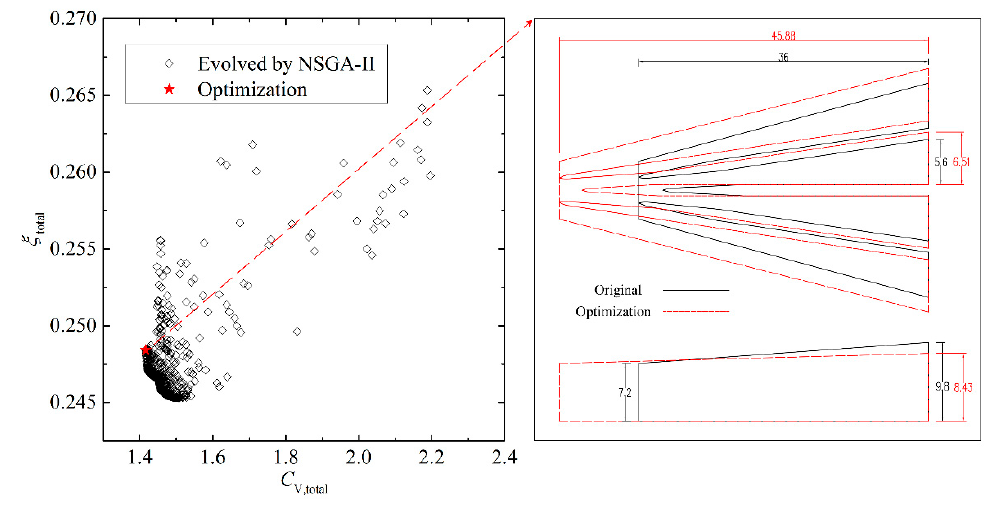
Figure 12. The process of objectives evolved through NSGA-II (dimensions in m). Table 7. The comparison of parameters between baseline case and optimum case.